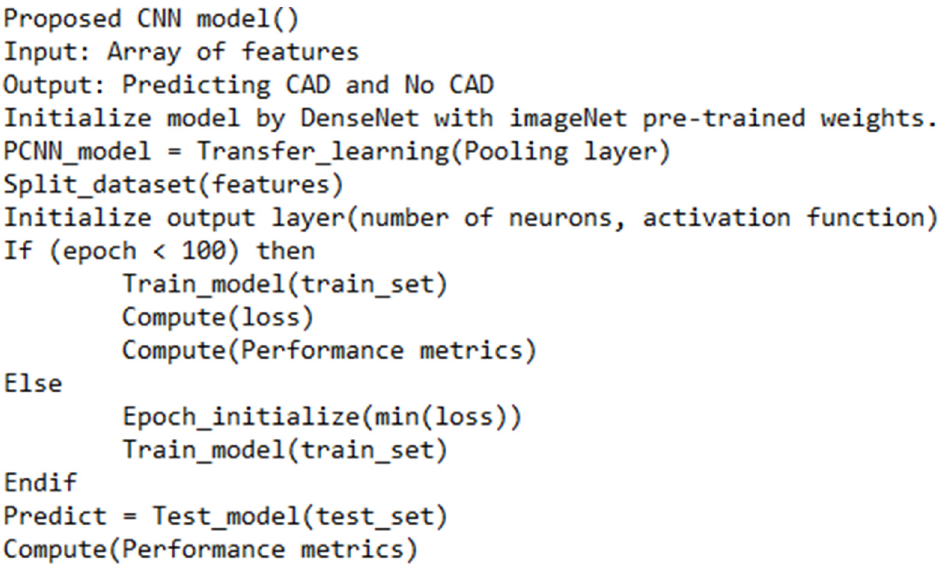
Figure 6. Proposed feature extraction algorithm.